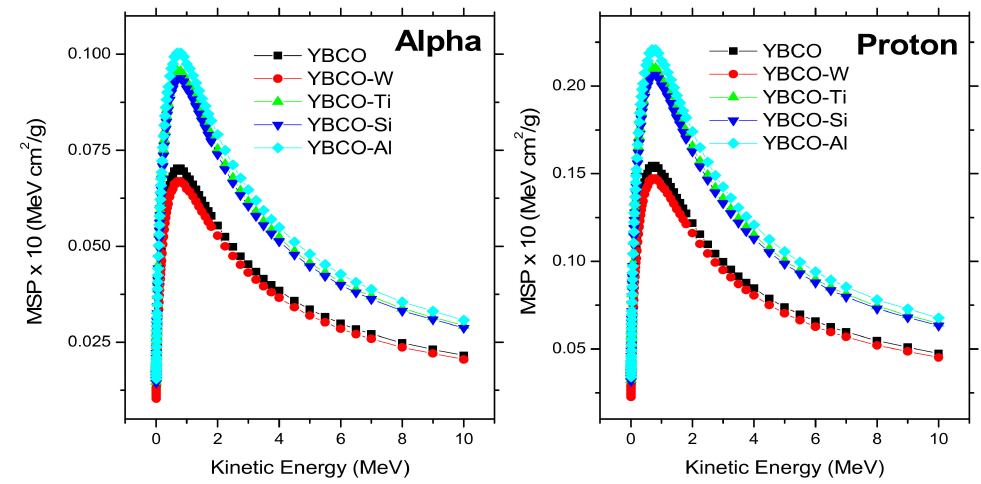
Figure 11. MSP values for proton and alpha versus the kinetic energy for fabricated ceramics.